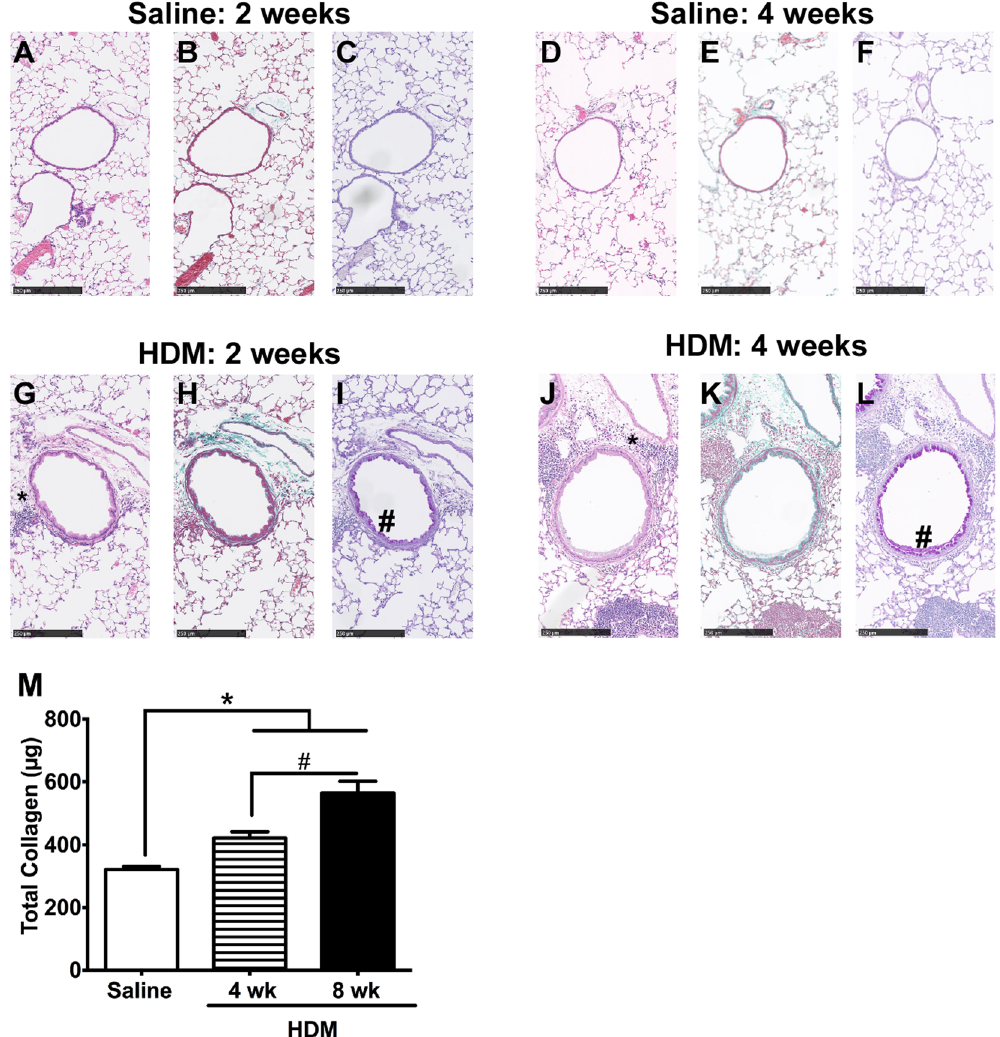
Figure 5. Airway remodeling with collagen deposition is observed in the 4-week HDM mice. Hematoxylin and eosin ( A , D , G , J ). Trichrome Mason staining ( B , E , H , K ) of paraffin embedded lung slices showed peribronchial inflammation infiltrates ( * ) in the 2-week ( G ) and 4-week (25 µ g) HDM mice ( J ), while subepithelial collagen deposition (stained green) was only detected in the 4-week model ( K ). Periodic acid-Schiff staining ( C , F , I , L ) revealed goblet cell hyperplasia (#) in both the 2-week (100 µ g HDM) ( I ) and 4-week (25 µ g HDM) models ( L ). (Representative of 4 animals/group; size bar = 250 µ m). Total collagen content ( M ) was increased in the 4- and 8-week HDM lungs, and was the highest at 8 weeks (p < 0.05 vs. Saline control, # p < 0.05 between the 4- and 8-week HDM groups, n =